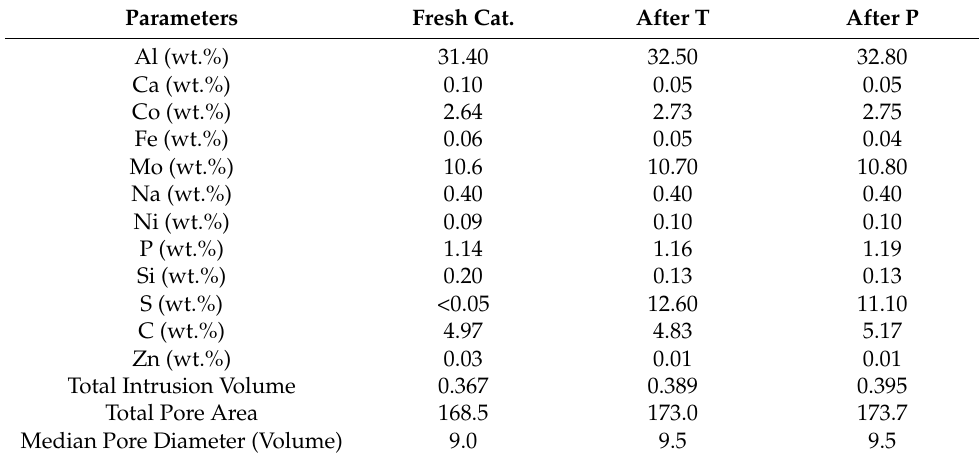
Table 10. Properties of the catalysts after the hydrogenation of the pyrolysis oils. Parameters Fresh Cat. After T After P